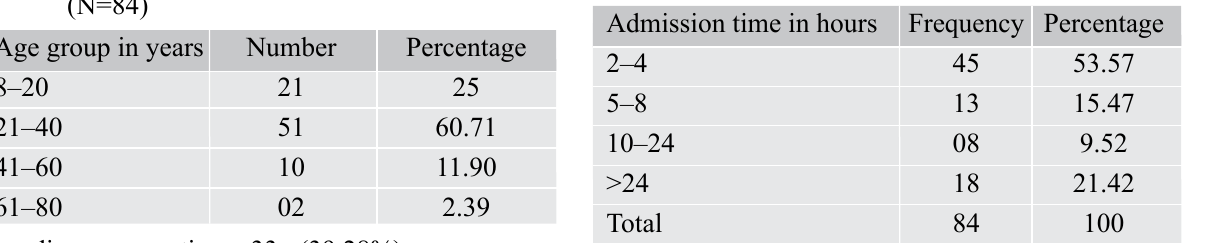
Table IV: Admission time after ingestion of poison